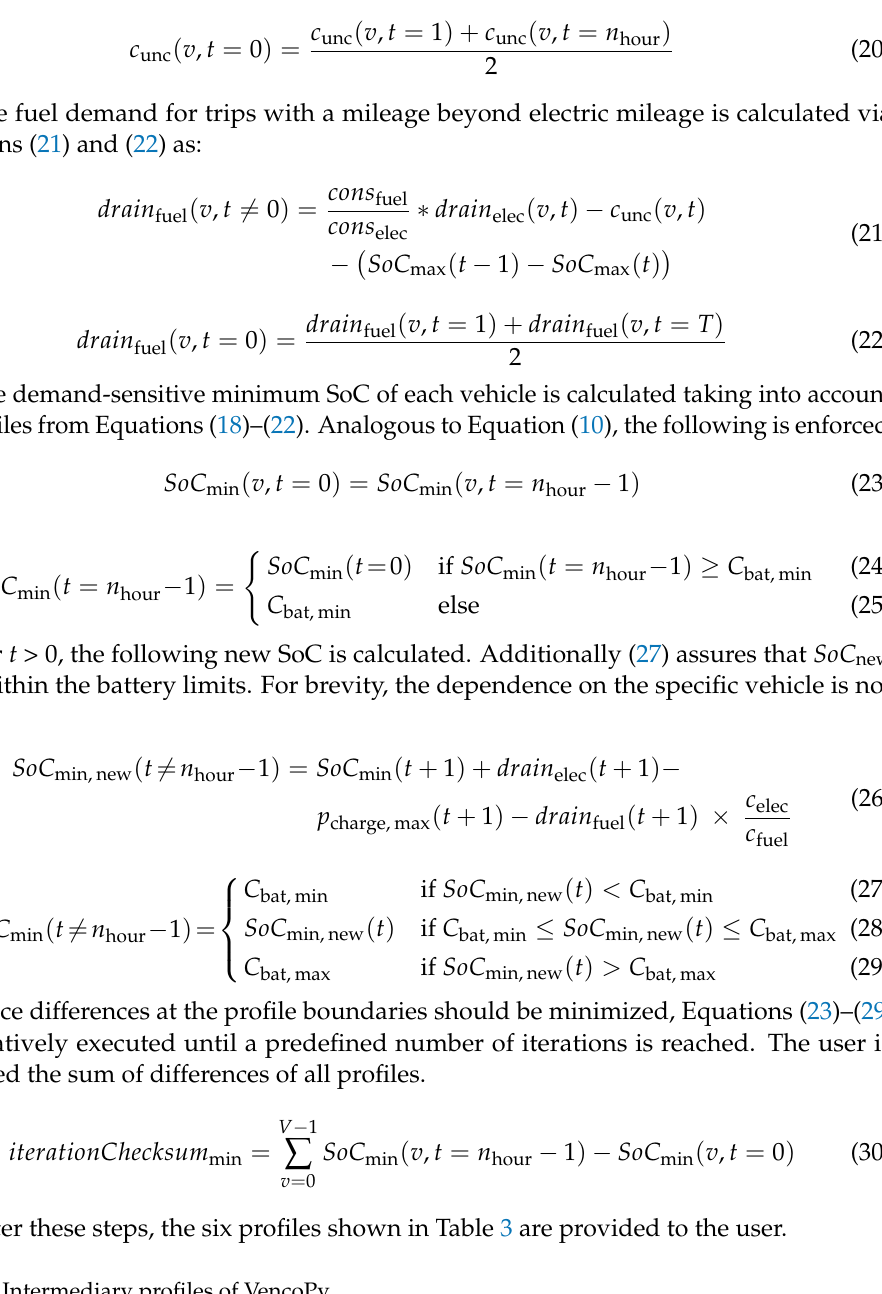
Table 3. Intermediary profiles of